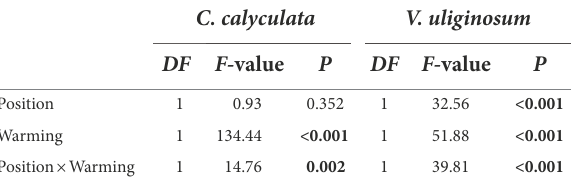
(Table 3). The warming effects on the chemical properties differed